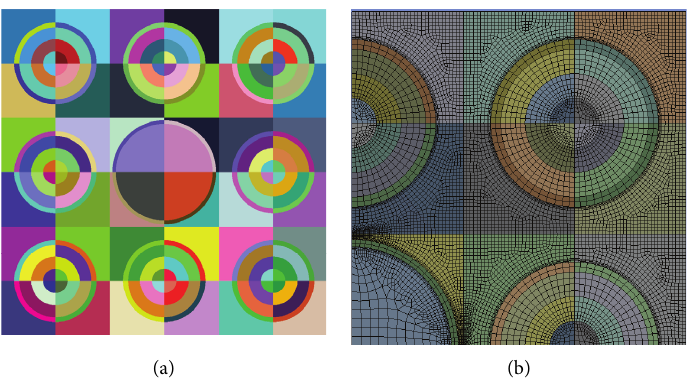
Figure 6: Cell division and meshing for 3 x3 fuel pins. (a) Cell division in OpenMC. (b) Meshing for